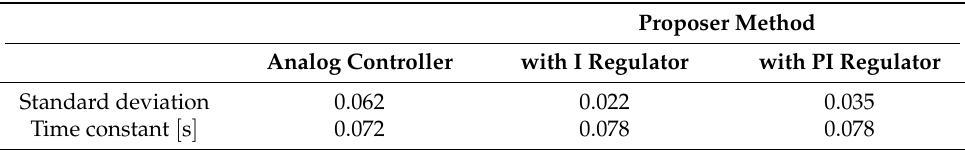
Table 2. Standard deviation and time constant of the motor at the